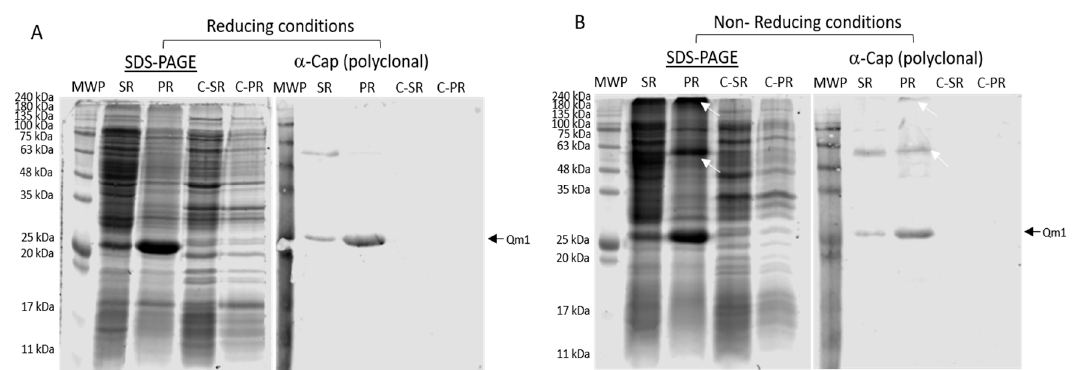
Figure 7. The identification of Qm1 expressed in the SHuffle ® T7 Express E. coli strain. ( A ) SDS-PAGE Coomassie